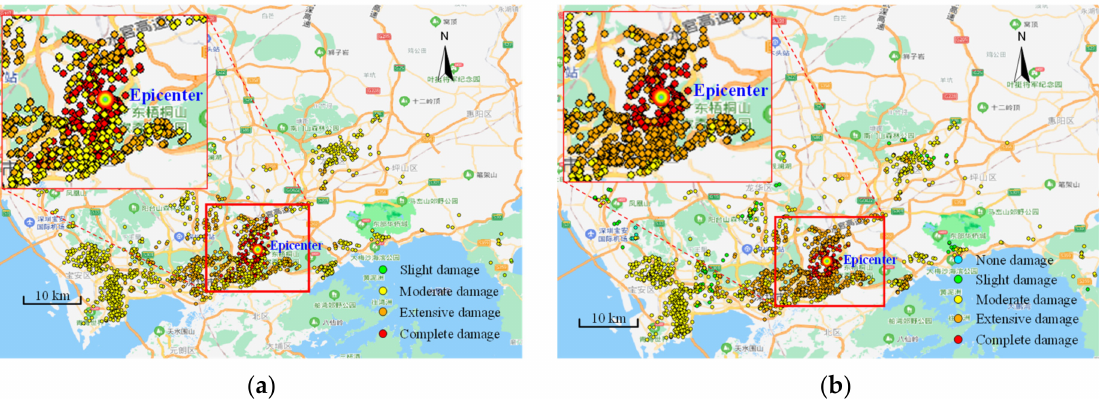
Figure 19. Distribution of damage states of the M7.5 earthquake scenario: ( a ) time history analysis results; ( b ) MI- CNN